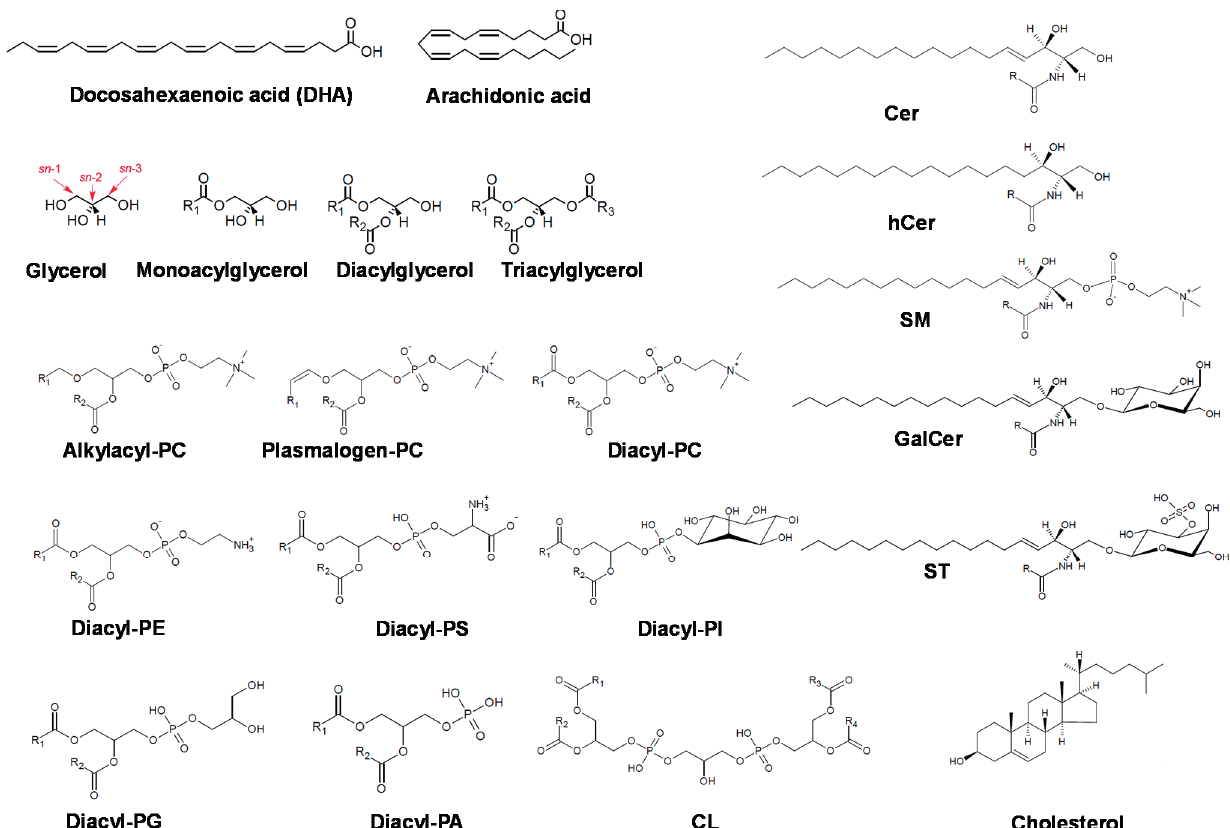
Figure 3. Examples of lipid structures. Cer: ceramide; hCer: hydroxyceramide; SM: sphingomyeline; PC: phosphatidylcholines; GalCer: galactosylceramide; PE: phosphatidylethanolamine; PS: phosphatidylserine; PI: phosphatidylinositol; ST: sulfatide; PG: phosphatidylglycerol; PA: phosphatidic acid; CL: